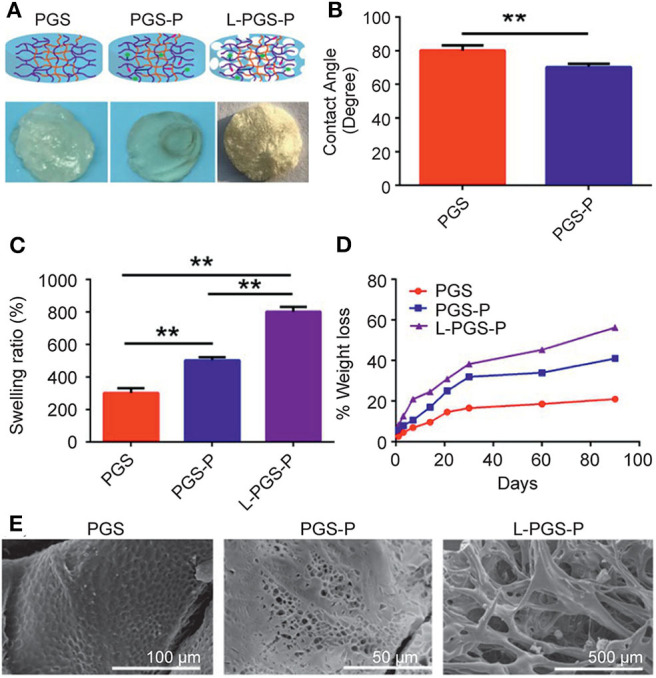
Physical properties of different scaffolds. (A) Macroscopic view of PGS, PGS-P, and L-PGS-P scaffolds. (B) Water contact angle was performed on PGS and PGS-P. (C) Swelling ratio (**p < 0.01 significance to P for 24 h). (D) Degradation performance of PGS, PGS-P, and L-PGS-P scaffolds. (E) SEM image of PGS, PGS-P, and L-PGS-P.